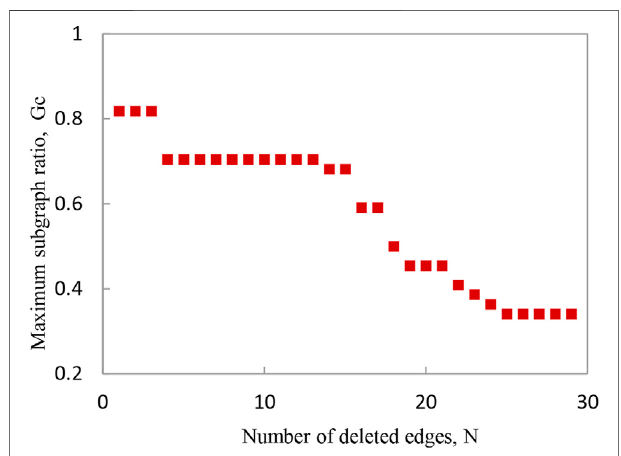
FIGURE15 | Thediagram ofpipeline networkmaximum subgraph ratio.